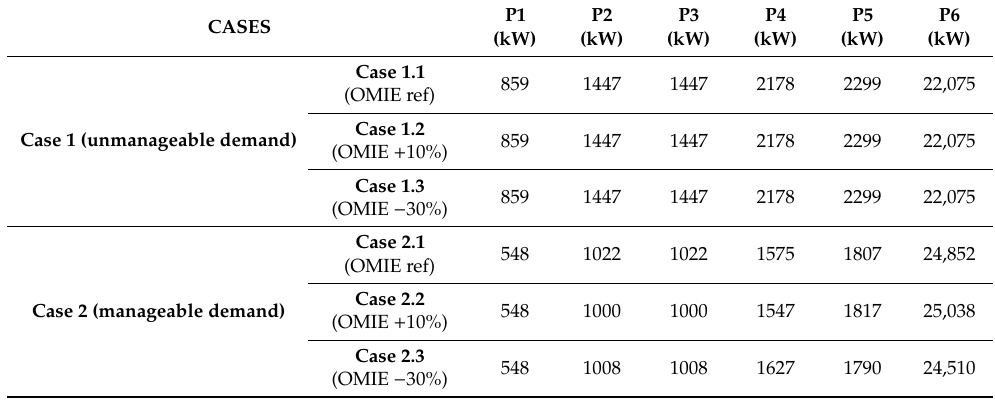
Table 10. Optimal demand contracted in each pricing period of all case studies.